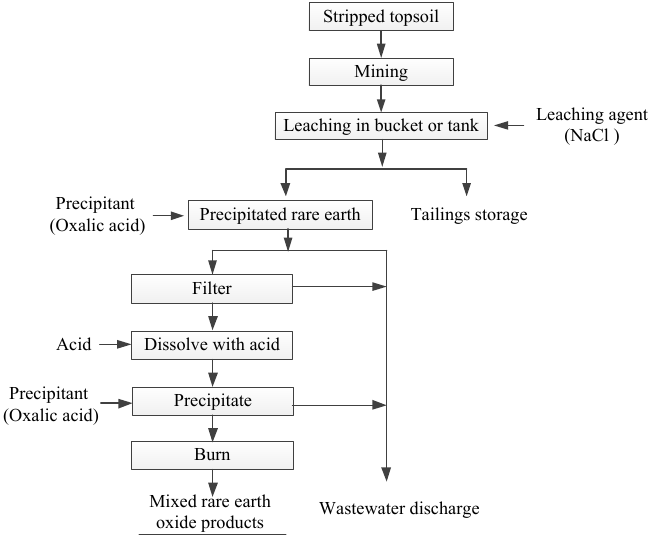
Figure 5. First generation leaching extraction process.